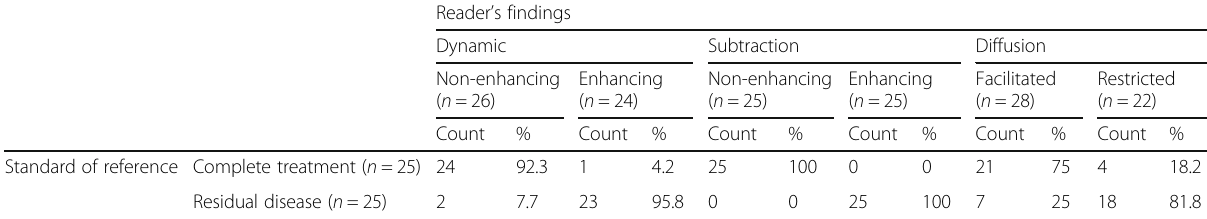
Table 2 Correlation of dynamic, subtraction, and diffusion findings obtained by reader 1 to standard of reference